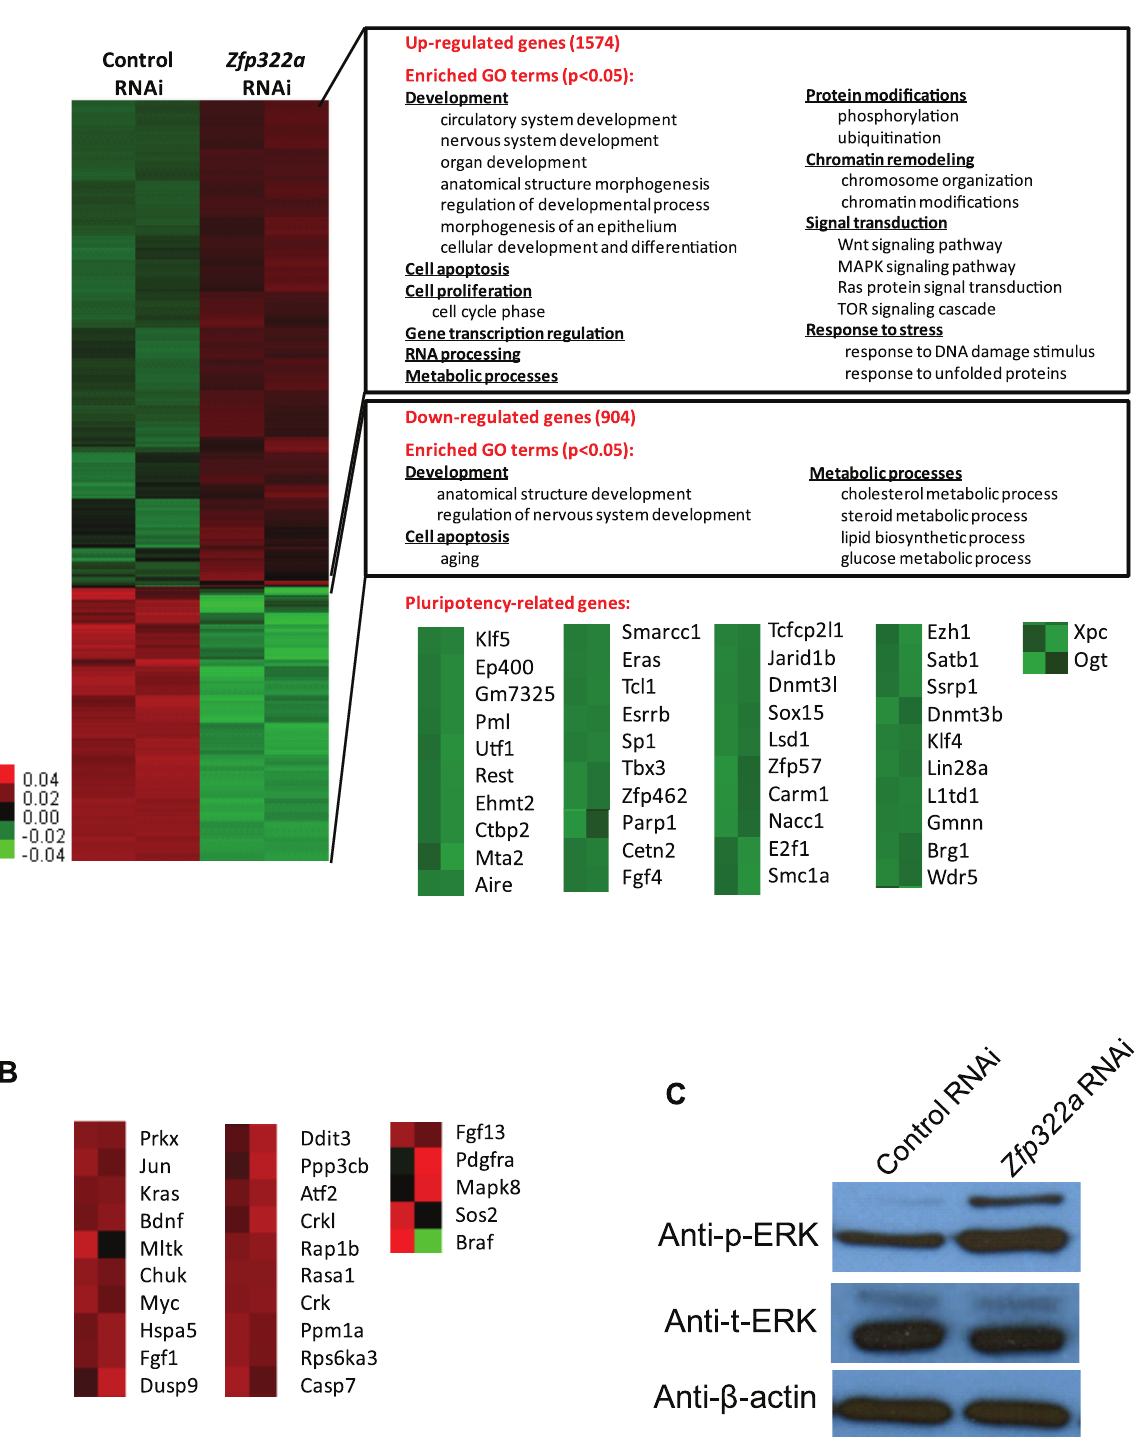
Figure 2. Changes of global gene expression upon Zfp322a knock-down in ES cells. ( A ) Microarray heat map generated from relative gene expression levels. Zfp322a was knocked down in E14 cells and the cells were selected for 96 hours before whole genome cDNA microarray hybridization was performed. Duplicates were performed to ensure reproducibility of results. Relative highly expressed genes were shown in red and low expressed genes in green. 1574 genes showed an increased expression level of more than 1.5 fold after Zfp322a RNAi. Gene onthology analysis was performed relating to ‘‘biological process’’. The enriched terms were classified into several function groups and listed in the figure. Many terms related to developmental processes were enriched. 904 genes expression level showed more than 1.5 fold reduction. Examples of down-regulated pluripotency-related genes upon Zfp322a knock-down in ES cells. Genes were selected according to their known functions in pluripotency or ES cells. Each selected gene was taken as individual tiles from the thumbnail-dendogram duplicates. ( B ) List of up-regulated MAPK pathway related